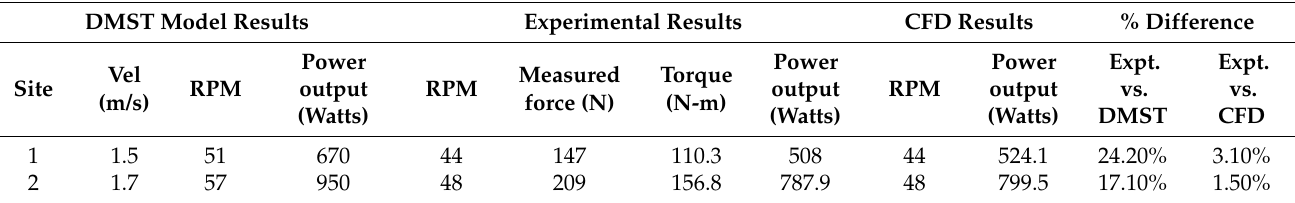
Table 6. The comparison of experimental and theoretical results of site 1 and site 2.